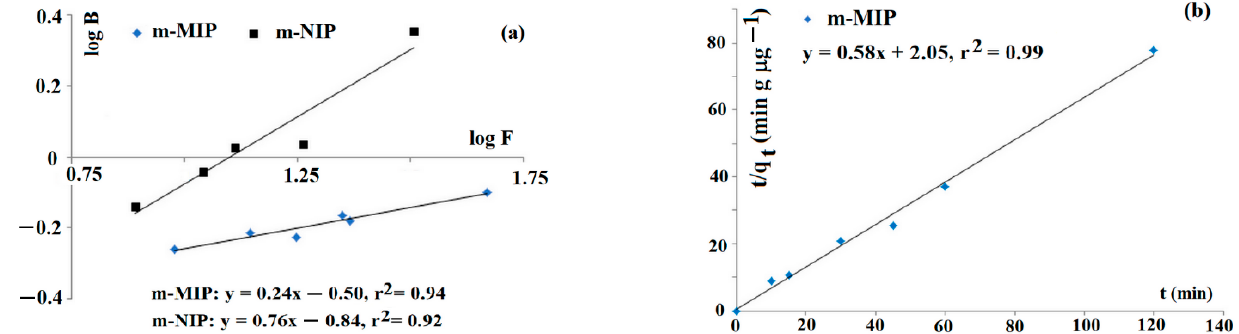
Figure 1. Freundlich isotherms for tyramine on m-MIP and m-NIP ( a ) and kinetic of adsorption on m-MIP ( b ).